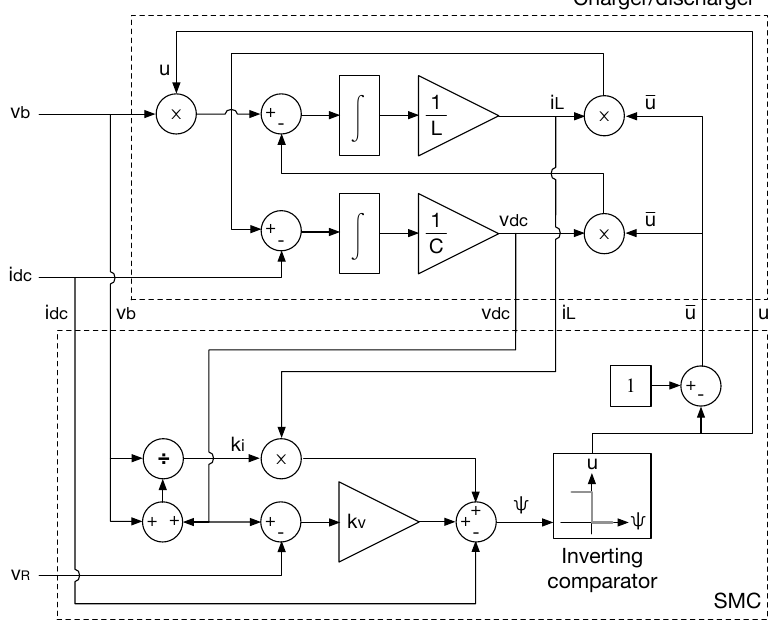
Figure 2. Block diagram of the charger–discharger with the Sliding-Mode Controller